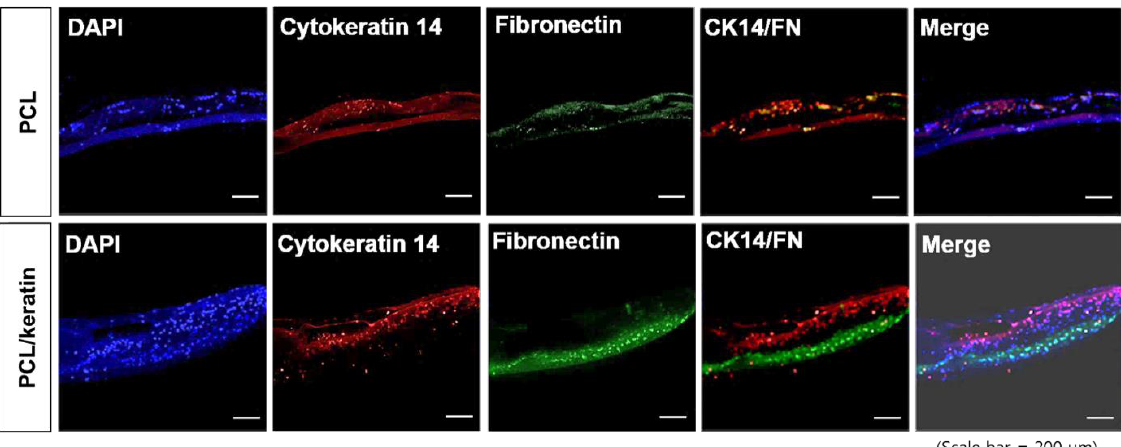
Figure 6. Immunocytochemistry results of the co-cultured scaffolds. (Scale bar = 200 μm). HaCaT cells were seeded 3 days (72 h) after NHDF seeding. On day 4 (96 h) after NHDF seeding, the HaCaT created a layer, which was stained by cytokeratin-14. Beneath the HaCaT layer, the NHDF produced a layer stained by fibronectin.